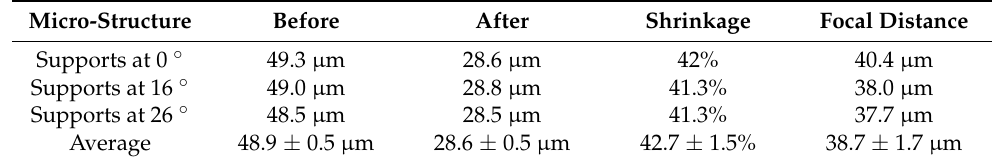
Table 1. The micro-lenses geometrical and focusing characteristics. The micro-structures were fabricated with the same dimensions over three different support structures, measured using SEM before and after calcination. The values of diameters were retrieved by a side view of the micro-lenses, as shown in Figure 3, and the focal distance was measured as visualized in Figure 1. The shrinkage ratio and averaged values were calculated